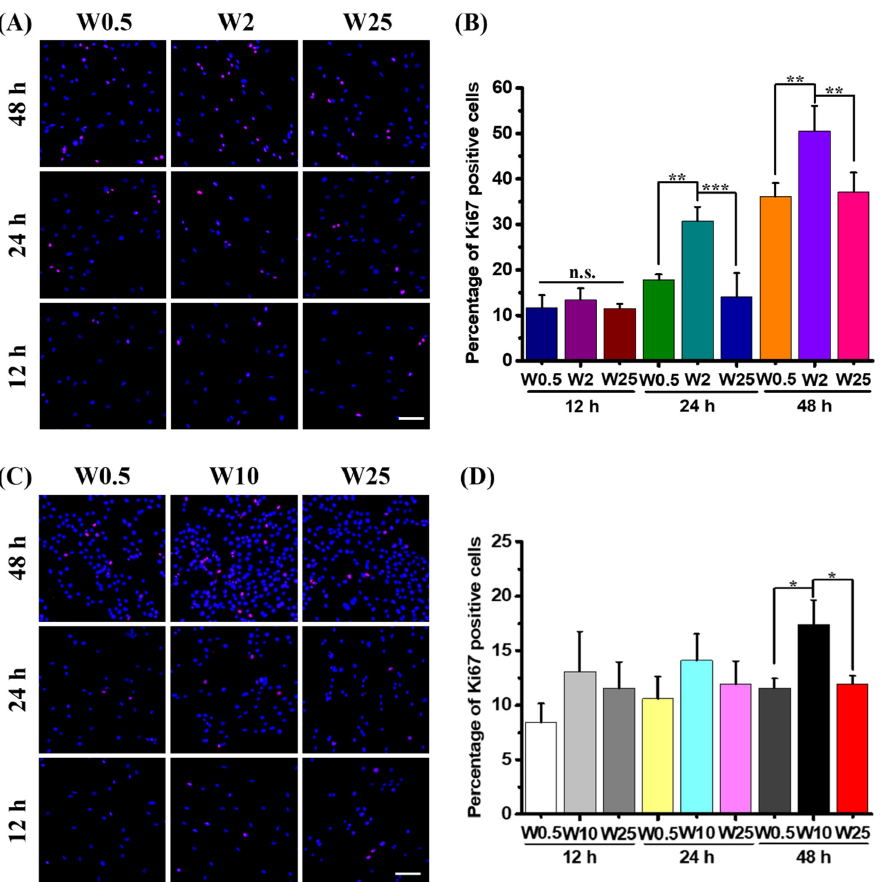
Figure 6. Cell proliferation assay. ( A ) Representative fluorescence images hBM-MSCs cells cultured on W0.5, W2, and W25 for 12 h, 24 h, and 48 h. The ki67 positive cells were stained in red, and cell nuclei were counterstained in blue (DAPI). ( B ) Quantification results of the percentage of Ki67 positive cells of hBM-MSCs at 12 h, 24 h, and 48 h for the chosen substrate. ( C ) Representative fluorescence images myoblast cells cultured on W0.5, W10, and W25 for 12 h, 24 h, and 48 h. ( D ) Quantification results of the percentage of Ki67 positive cells of myoblast cells at 12 h, 24 h, and 48 h for the chosen substrate. Three independent experiments were performed. Data are shown as mean ± standard deviation (SD), and * p < 0.05, ** p < 0.01, *** p < 0.001, n.s. no significant difference. Scale bar is 100 µm and applies to all images.